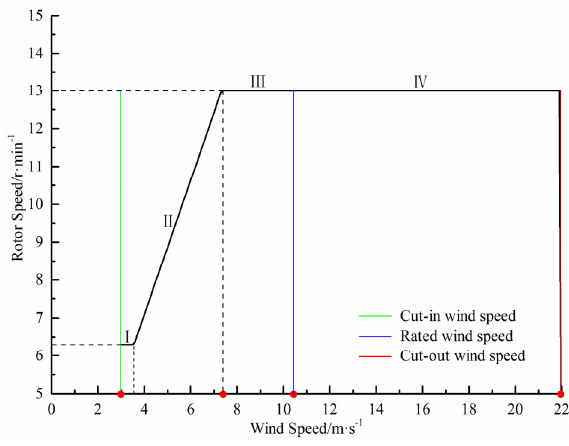
Figure 5. Rotor speed